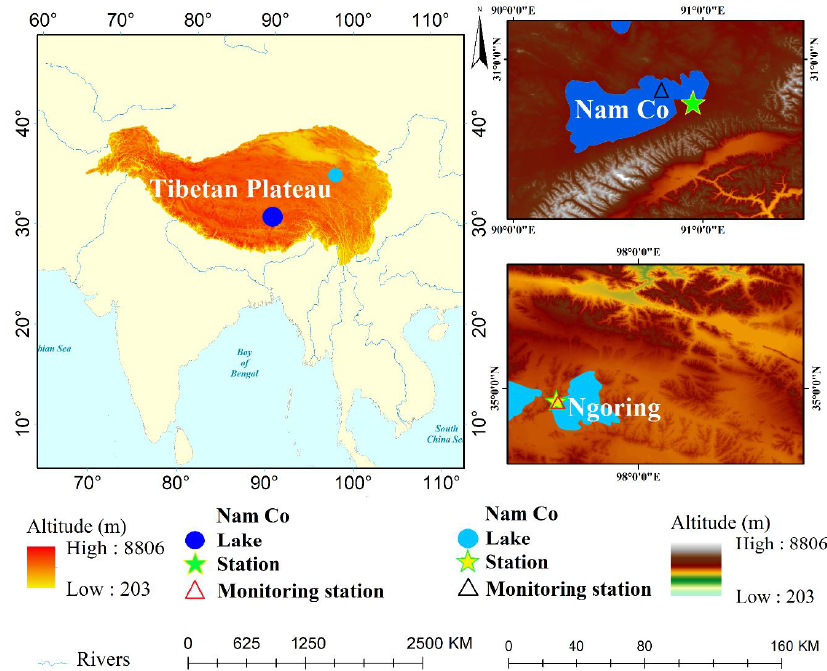
Figure 1. The topography around Lake Nam Co and Lake Ngoring, and the location of Nam Co station (upper right), and of Ngoring station (lower right). The location of the monitoring station at Lake Ngoring for ice albedo, and at Lake Nam Co for lake surface temperature (LST), sensible heat flux (H) and latent heat flux (LE) is also marked.